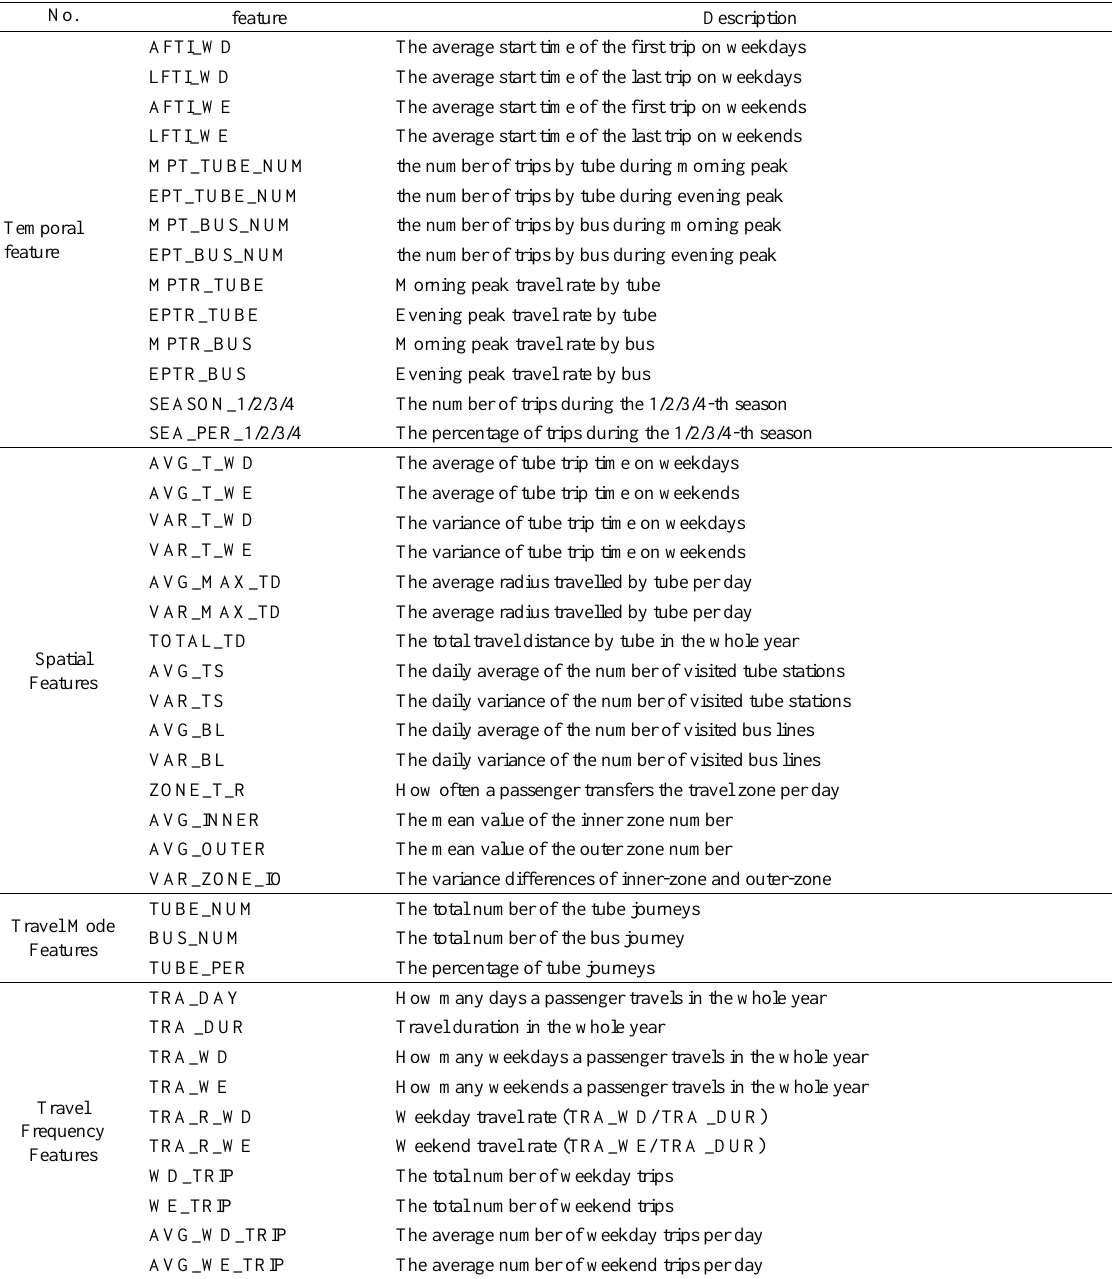
Table 1. Feature extracted from smart card